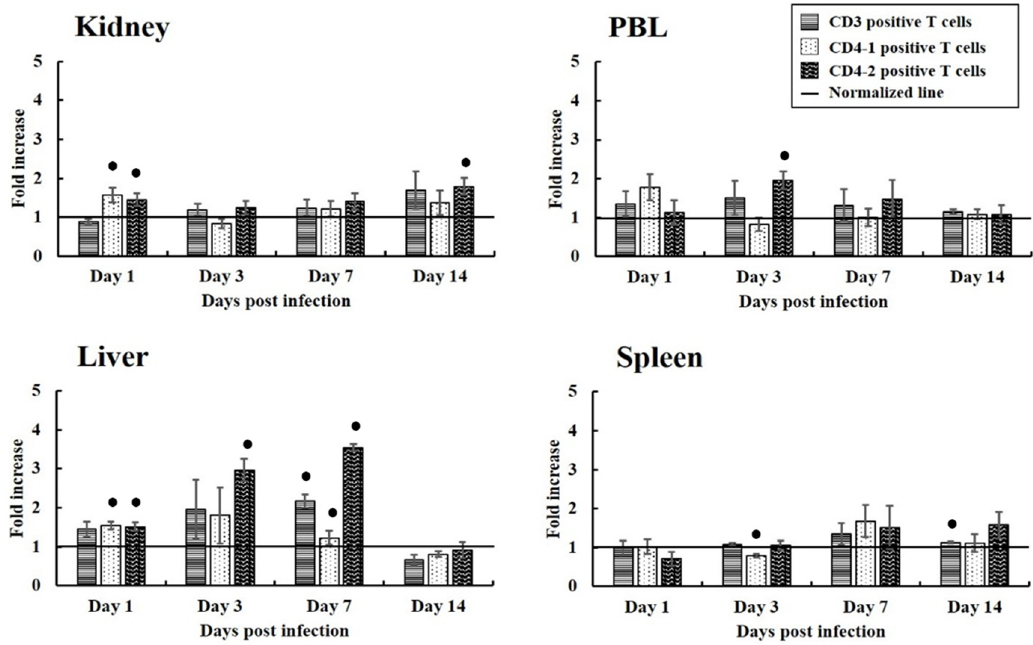
Figure 4. Fold increase in CD3 + , CD4-1 + , and CD4-2 + T cell populations during VHSV infection in olive flounder determined using flow cytometry. Leukocytes were isolated at 1, 3, 7, and 14 dpi from the kidney, liver, spleen and PBL ( n = 3) from the VHSV infection ( n = 30) and negative control ( n = 30) groups, respectively. CD3 + , CD4-1 + , and CD4-2 + T cell responses were observed and presented as fold increase compared to the T cell population in the negative control group (adjusted to 1 and shown by a solid line). Error bars indicate the standard deviation of the mean. Black circles ( ● ) represent a significant difference between the negative control and VHSV infection groups by Student’s t -test at a particular time point ( p < 0.05).